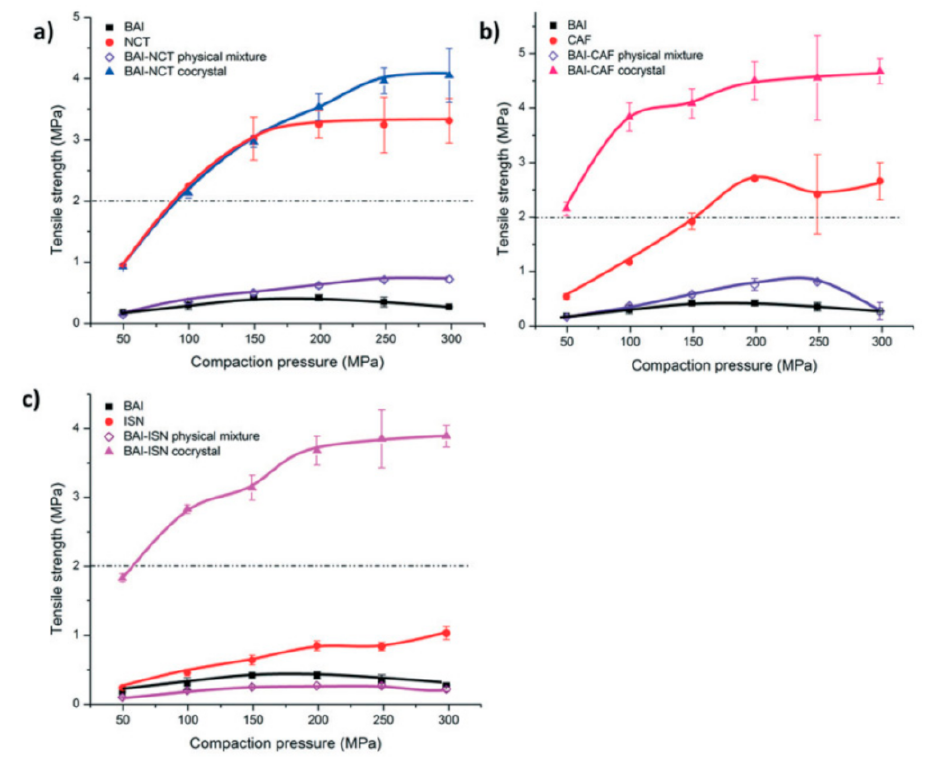
Figure 8. Tabletability of ( a ) BAI-NCT, ( b ) BAI-CAF, and ( c ) BAI-ISN cocrystal systems ( n = 3). Some error bars are hidden by symbols. The dashed lines correspond to 2 MPa tensile strength [69] (Reproduced from ref. [69] with permission from the Royal Society of